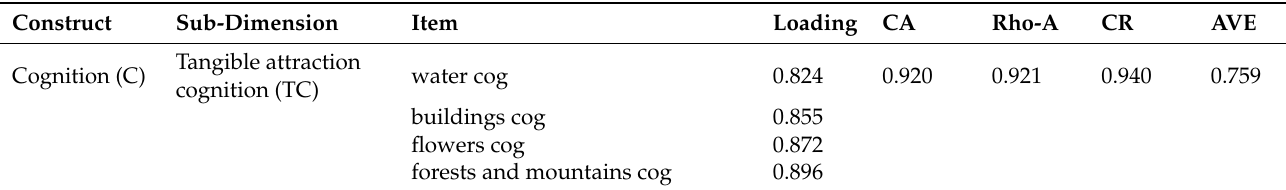
Table 7. Assessment of reflective measurement